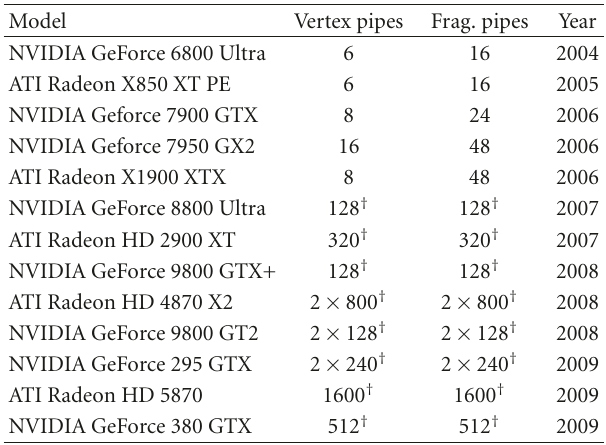
Table 1: Table describing how the number of pipelines in the GPU has changed. (The latest generation of graphics cards form the two main manufacturers, NVIDIA, and ATI, have unified shaders instead of specialized ones. These are marked with †